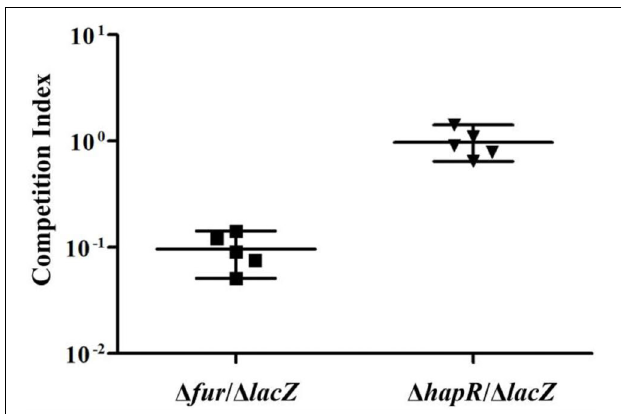
FIGURE 5 | Infant mouse competition assay using (cid:49) fur , (cid:49) hapR , and (cid:49) lacZ cells. The (cid:49) fur and (cid:49) hapR were competed against (cid:49) lacZ . The competitive index is the ratio of mutant to (cid:49) lacZ recovered from the intestine calculated by the ratio of input mutant to (cid:49) lacZ (inoculated into the mouse). Each data point represents the competitive index from an individual mouse. The line bar represents the geometric mean. The (cid:49) fur strain is significantly attenuated ( P < 0.01) by Student t